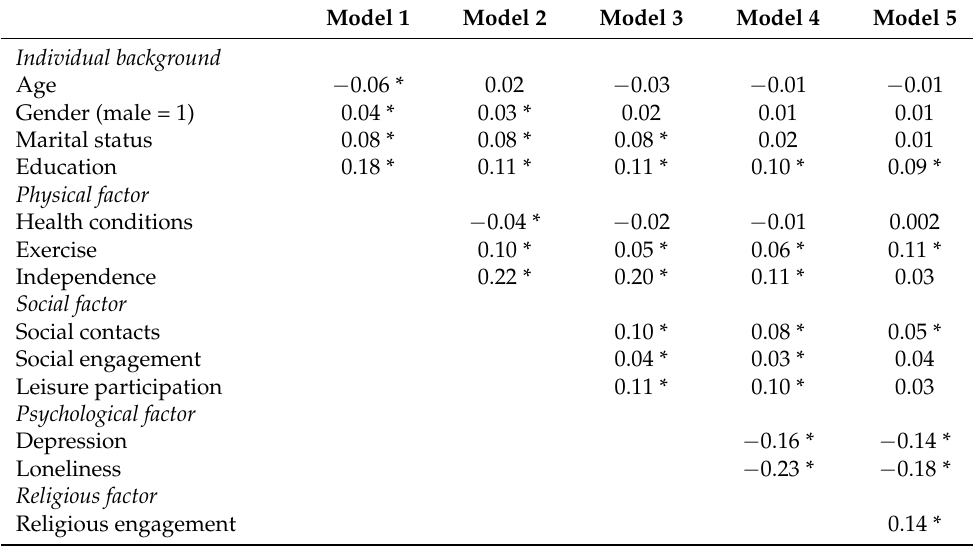
Table 2. Hierarchical regression analysis predicting life